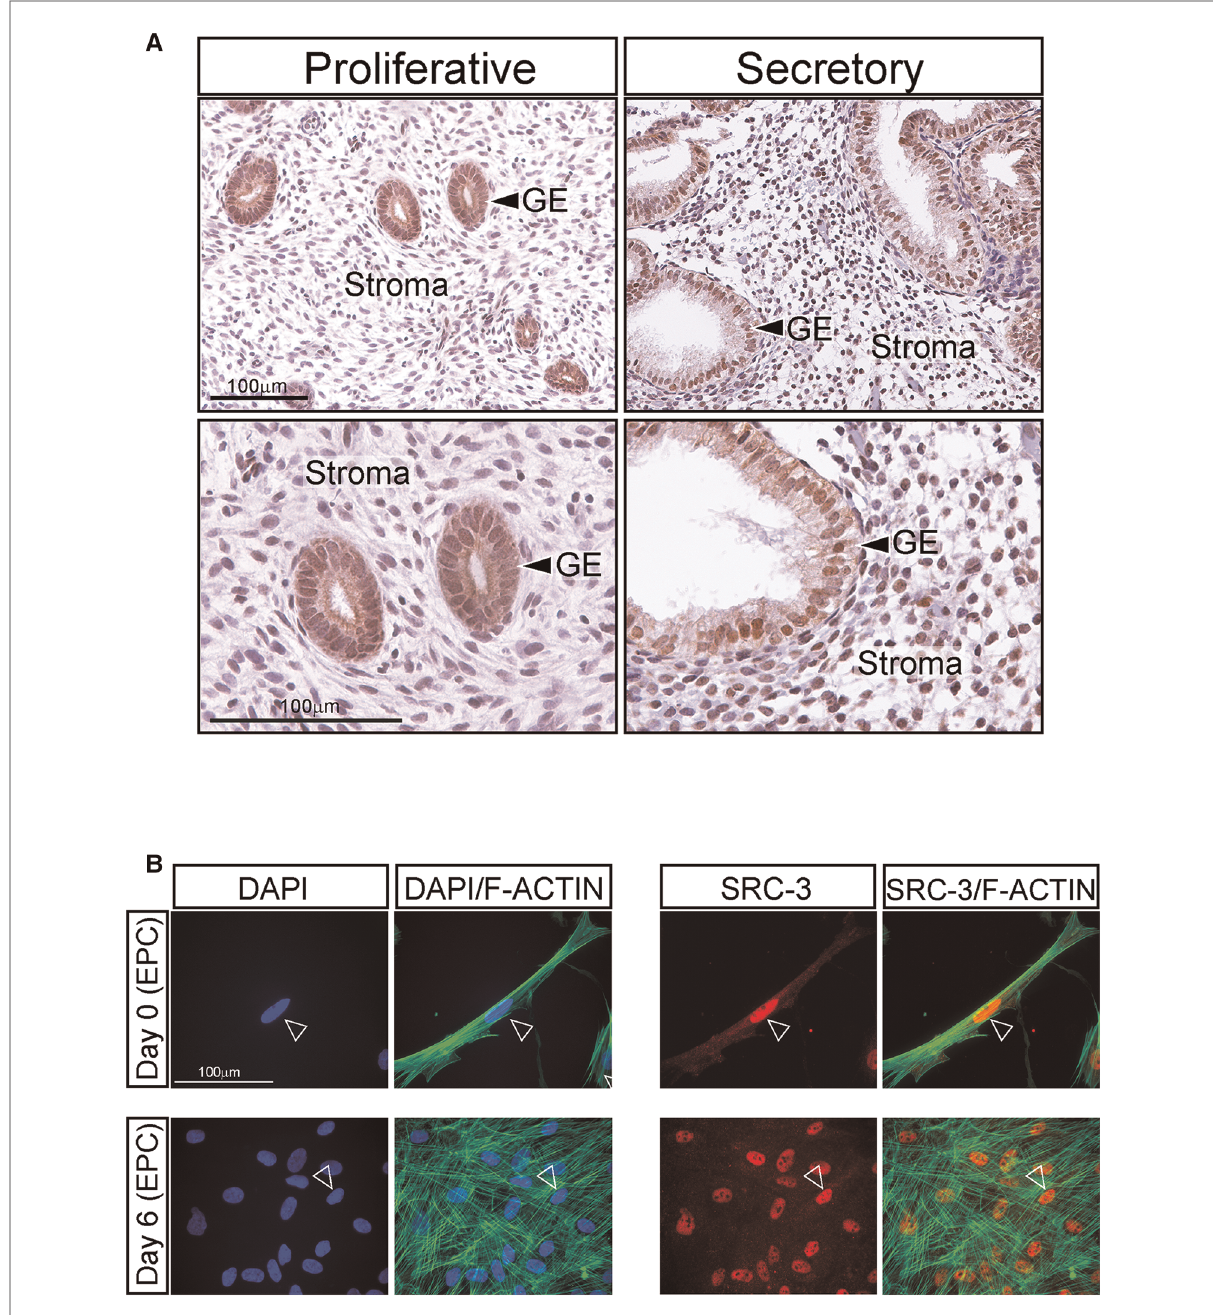
FIGURE 1 Expression of SRC-3 in human endometrial cells ( A ) left column of panels shows low and high power magni fi cation images (top and bottom panels respectively) of human endometrial tissue biopsied during the estrogen-dominant proliferative phase of the menstrual cycle, which was immunohistochemically stained for SRC-3 expression. Note that most glandular epithelial (GE) cells express nuclear localized SRC-3 while stromal cells express lower levels of SRC-3 at this stage of the cycle. Right column of panels displays low and higher magni fi cation images (top and bottom panels respectively) of human endometrial tissue biopsied during the progesterone-dominant secretory phase and stained for SRC-3 expression. Expression of nuclear SRC-3 is clearly detected in the GE cells, which exhibit a distinctive tortuous morphology at this stage of the cycle. Nuclear expression of SRC-3 in the stroma is clearly observed in the majority of cells. Scale bars in the top and bottom left panels apply to the top and bottom right panels respectively. ( B ) The left two columns show cultured T-HESCs stained with DAPI (blue nucleus) or DAPI (blue) plus phalloidin (green; binds F-actin) on day 0 and 6 of EPC treatment; arrowhead denotes nucleus of T-HESC. On day 0 of EPC treatment, T-HESCs exhibit a fi broblastic morphology with F- actin fi bers orientated parallel to each other. Following six days of EPC treatment, note the conspicuous spatial disorganization of the F-actin fi bers indicative of cellular transformation from a fi broblastoid to an epithelioid cell morphology (39). The two columns on the right show the same cells immuno fl uorescently stained for SRC-3 expression [red (arrowhead)] or SRC-3 (red) plus phalloidin (green). Note that SRC-3 is expressed in all T-HESCs at days 0 and 6 of EPC treatment with most of its expression localized to the nucleus (arrowhead). Scale bar applies to all